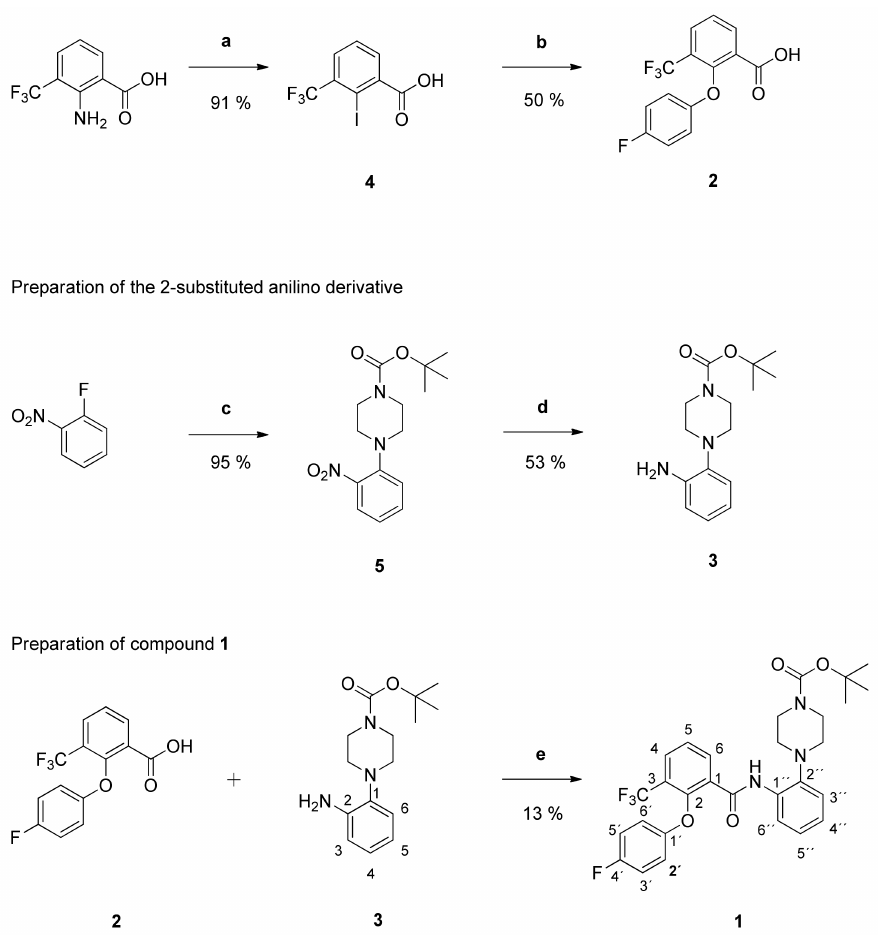
Figure 1. Preparation of compound 1 . Reagents and conditions: ( a ) (1) H 2 SO 4 30%, DMSO, 0 ◦ C, 5 min; (2) NaNO 2 , rt, 2 h; (3) KI, H 2 O, rt, 1 h; (4) KI, H 2 O, rt, 1 h; ( b ) 4-fluorophenol, 1,8- diazabicyclo[5.4.0]undec-7-ene, Cu, CuI, pyridine, DMF, 160 ◦ C, 2 h; ( c ) N - Boc -piperazine, K 2 CO 3 , DMSO, 80 ◦ C, 72 h; ( d ) 15% (m/m) palladium on activated carbon, H 2 , Me OH, rt, 24 h; ( e ) (1) CH 2 Cl 2 , 0 ◦ C, 5 min; (2) 2-chloro- N -methylpyridinium iodide, diisopropylethylamine, rt, 24